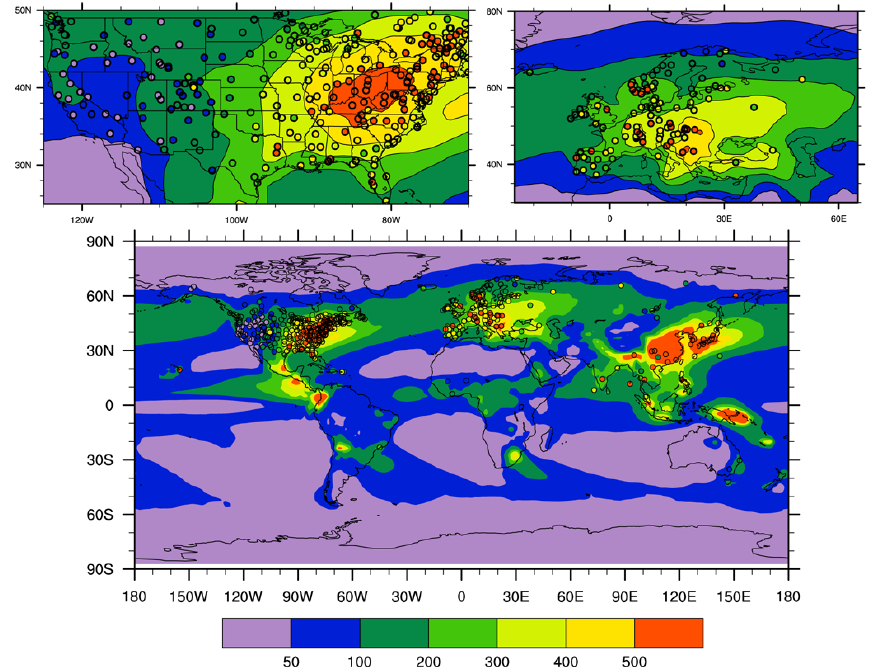
Fig. 1c. Sulfate wet deposition (mg(S)m − 2 yr − 1 ) for 2000. Contours are for the multi-model mean; filled circles are for the wet deposition network